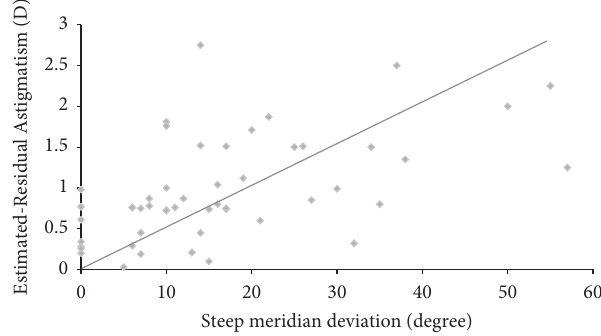
Figure 3: Pearson’s correlation between steep meridian deviation and estimated residual astigmatism. There was a positive corre- lation between steep meridian deviation and the estimated residual astigmatism D at 6 months ( r � 0.47, P < 0 .